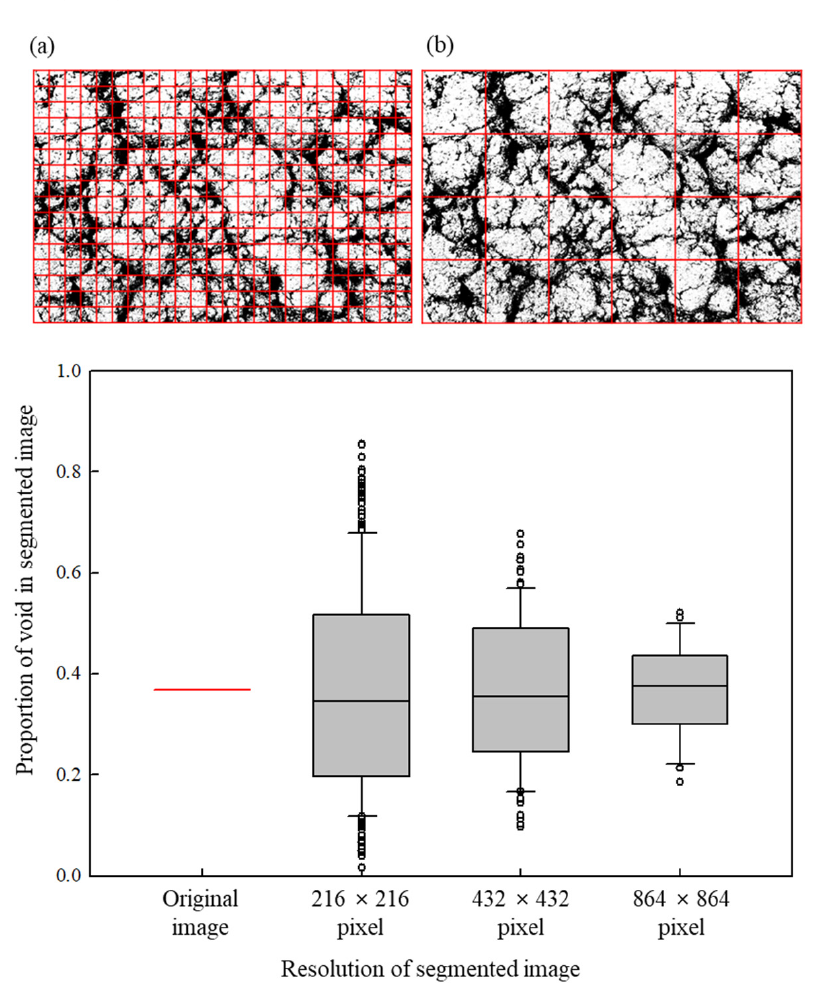
Figure 9. Difference in void distribution among segmented images. ( a ) is the binary image divided into 384 segmented images of 216 × 216 pixels. ( b ) is the binary image divided into 24 segmented images of 216 × 216 pixels. Black pixels in ( a , b ) represent the void. The solid red line in the graph is the average gray value of the original image, and the number of segmented images for each resolution was 384, 96, and 24, respectively.